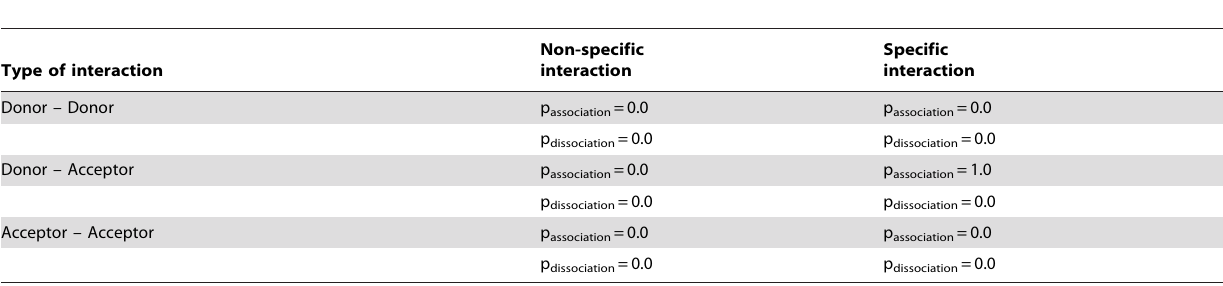
Table 2. Simulation parameters: Association and dissociation probabilities used for the simulation of non-specific and specific